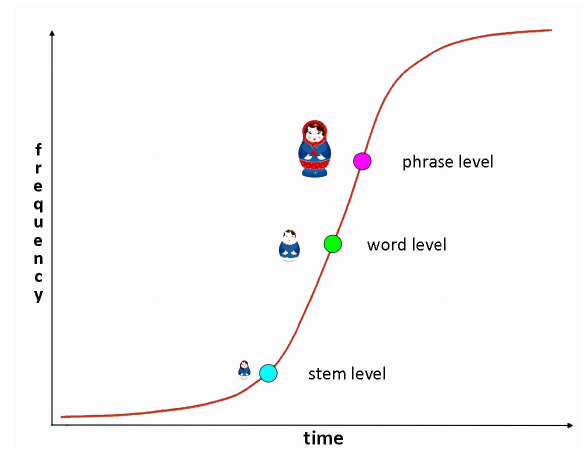
Figure 2: The predictions of the life cycle in a model with variable